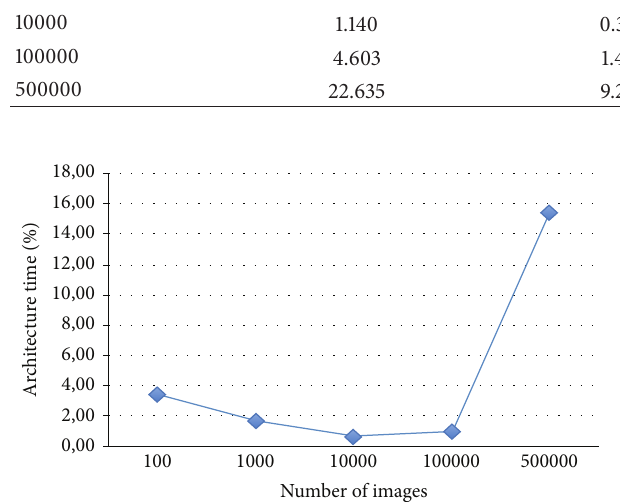
Figure3:Percentageofarchitecturetimewithrespecttothenumber of images, retrieval